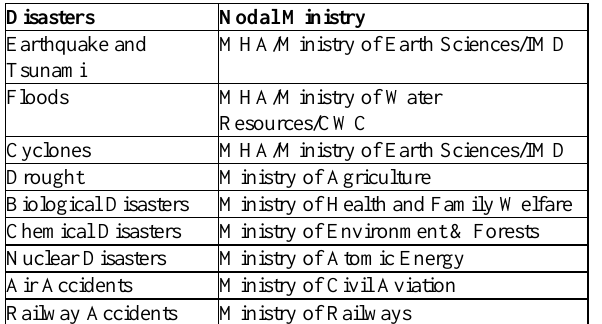
Table 1: Nodal Ministries for Disaster Management Based on the information available with various ministries, Table 2 provides specific disaster type focus and department/division of the ministries